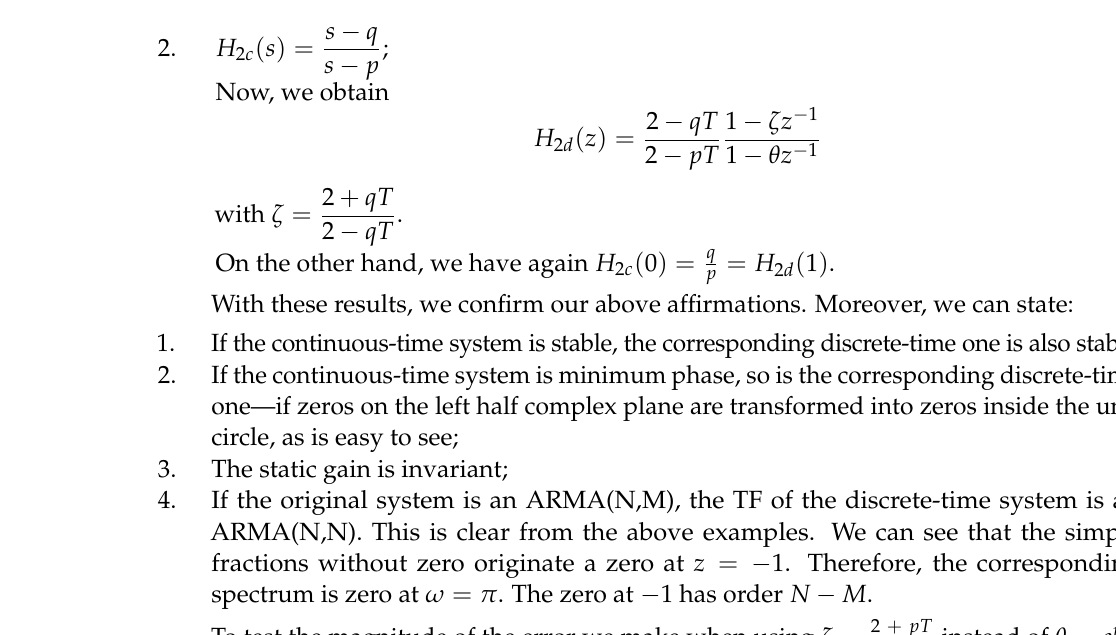
Table 1. Approximations of θ = e pT , by ζ = 2 + pT